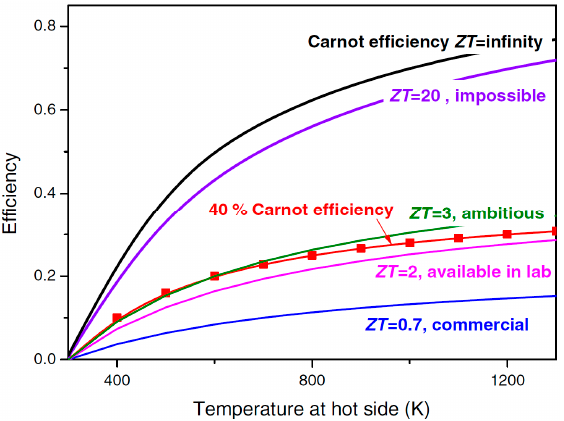
Figure 20. Conversion e ffi ciency of TE materials vs. ∆ T (for T cold = 300 K ) and ZT [148]-reprinted by Figure 20. Conversion efficiency of TE materials vs. Δ𝑇 (for 𝑇 (cid:3030)(cid:3042)(cid:3039)(cid:3031) = 300𝐾 ) and ZT [148]-reprinted by Figure 20. Conversion efficiency of TE materials vs. Δ𝑇 (for 𝑇 (cid:3030)(cid:3042)(cid:3039)(cid:3031) = 300𝐾 ) and ZT [148]-reprinted by permission from Springer Nature. permission from Springer Nature. permission from Springer Nature.